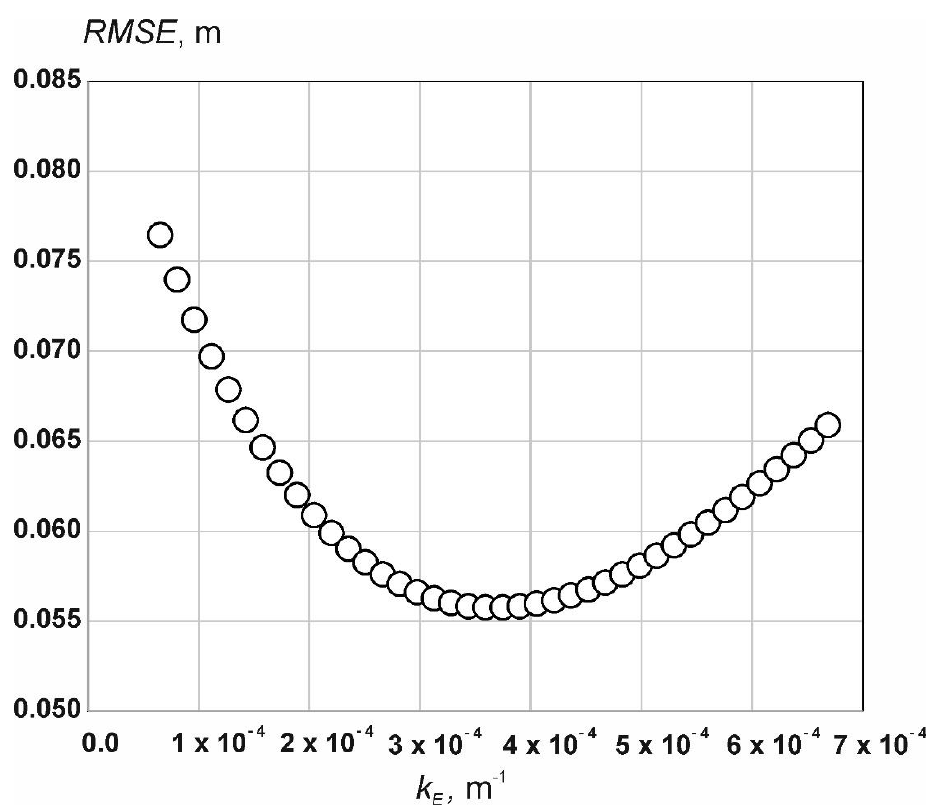
Figure 3. The result of model calibration.